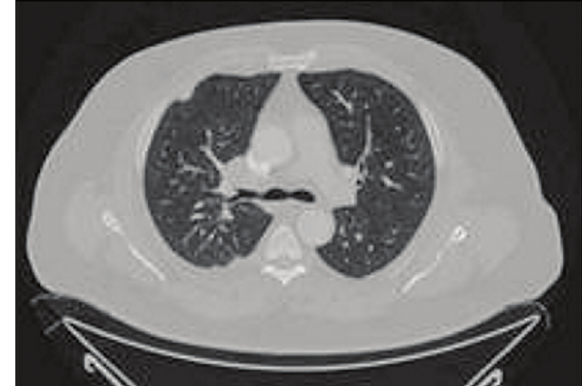
Figure 2 – Patient 1: CT scan showing pleural effusion among pleural metastasis.